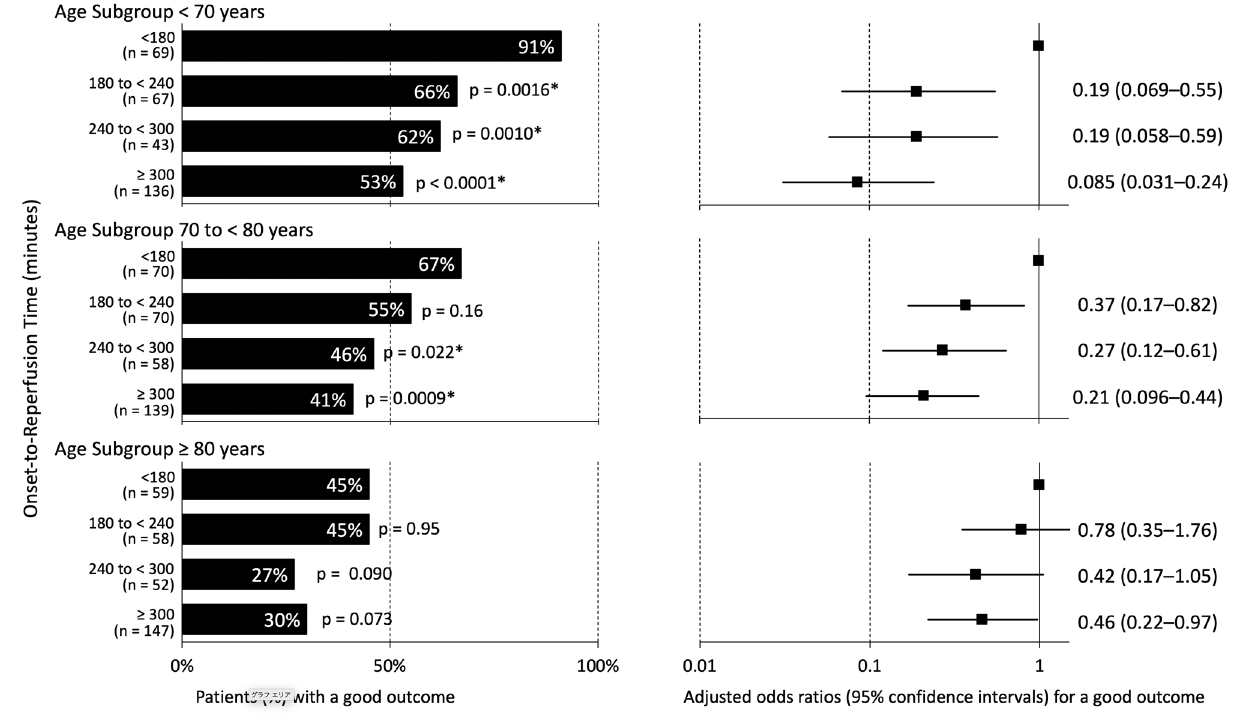
Figure 3. Proportions of a good outcome and adjusted odds ratios for a good outcome according to onset-to- reperfusion time (ORT) categories in each age subgroup. The proportion of a good outcome (defined as mRS score ≤ 2) was lower in the delayed ORT categories than in those with ORT < 180 min in each age subgroup, although the association was marginal in patients aged ≥ 80